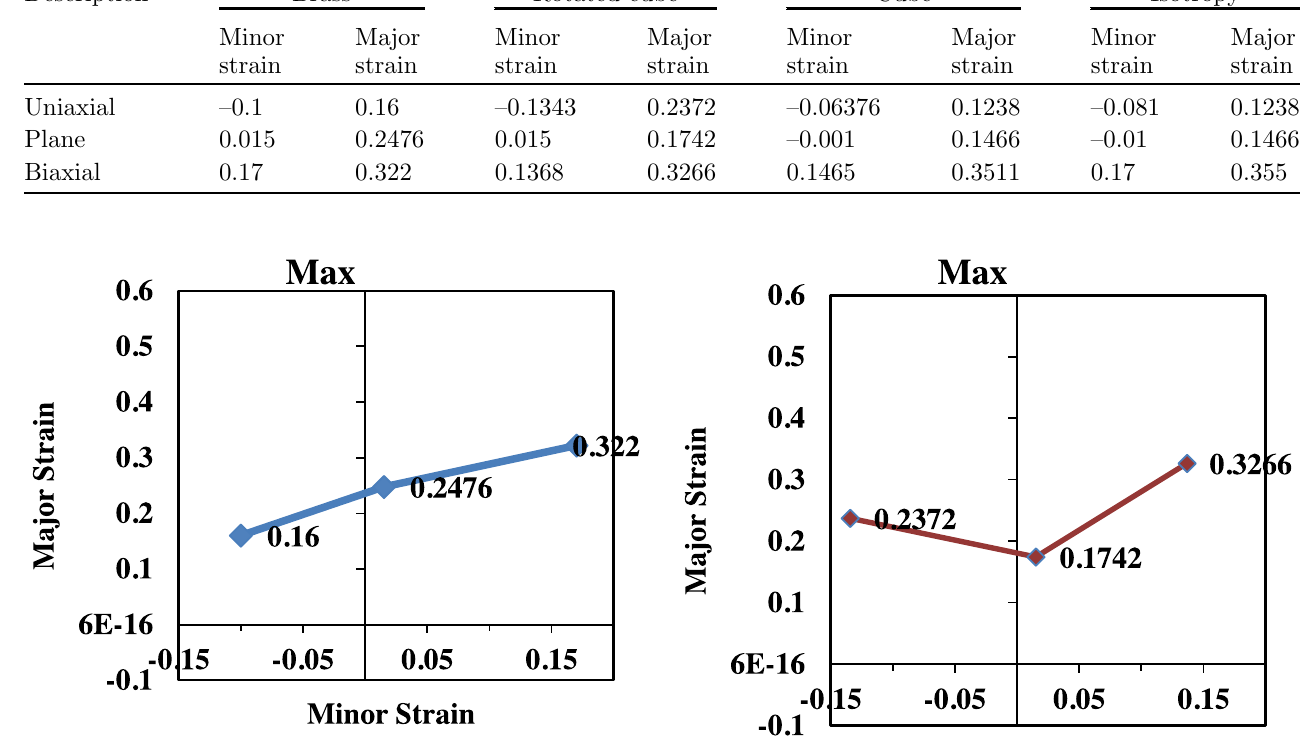
Fig. 16. Forming limit diagram for brass orientation (cid:4) numerical simulation.